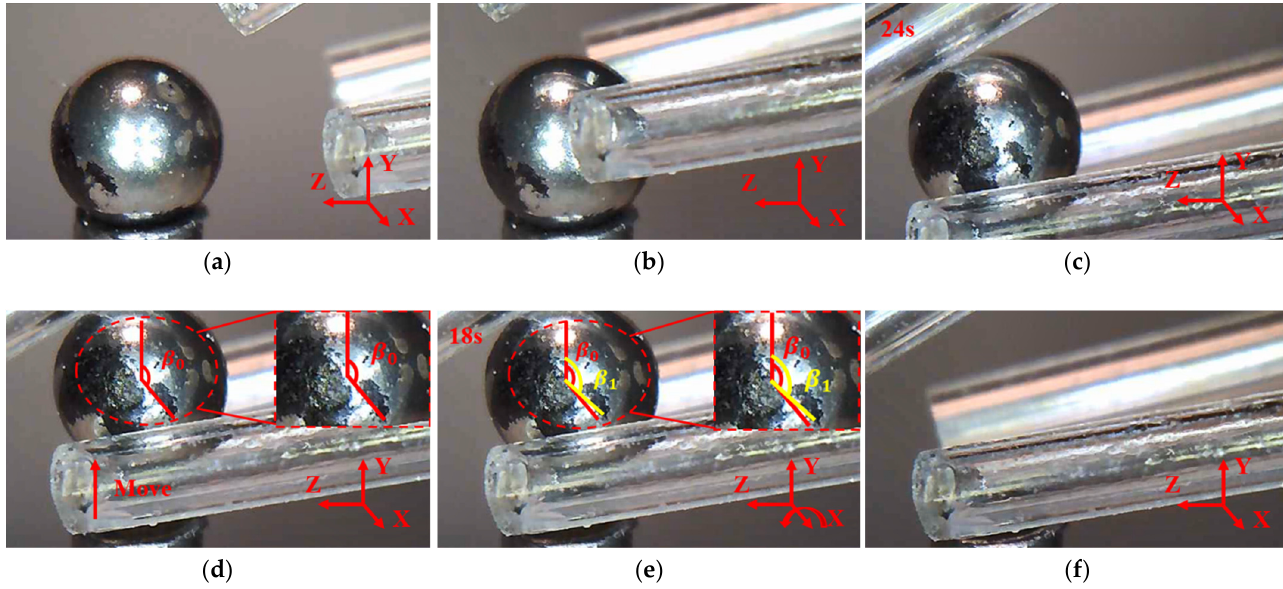
Figure 18. Manipulation of a micro ball: ( a ) Initial state; ( b ) the micro gripper tips are moved to enclose the micro ball; ( c ) the micro ball is gripped; ( d ) the micro ball is moved to a distance; ( e ) the micro ball is rotated about axis X; ( f ) the micro ball is released.